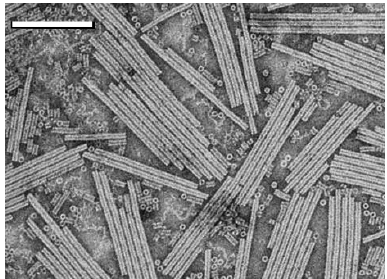
Figure 1. Electron micrograph of tobacco mosaic virus (TMV) on a substrate. Reprinted with